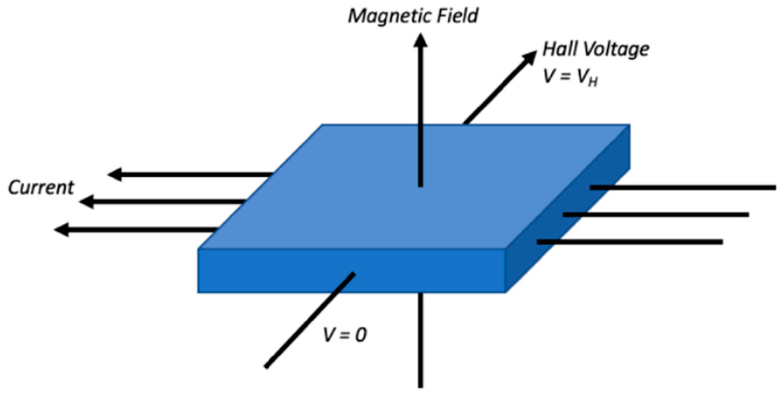
Figure 8. Hall e ff ect in a thin sheet of conductive material [43]. Figure 8. Hall effect in a thin sheet of conductive material [43].